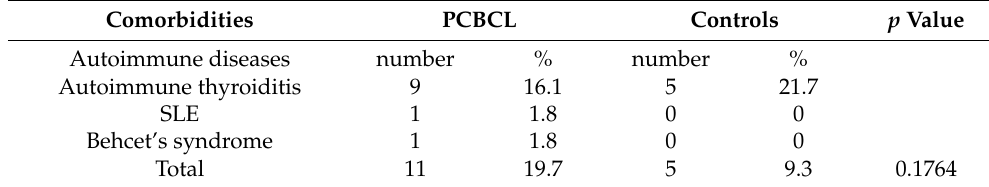
Table 4. Frequency of autoimmune diseases in patients with PCBCL and